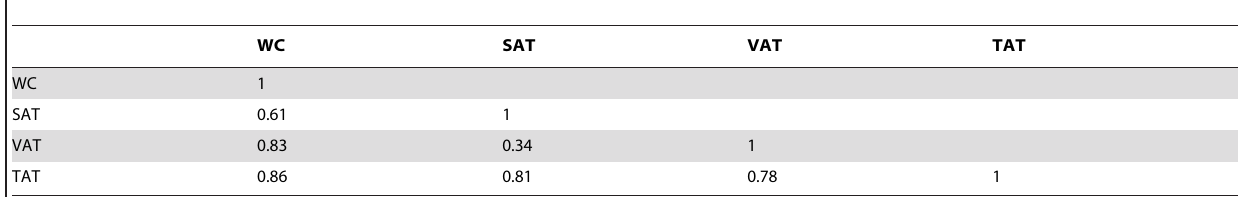
Table 3. Spearman correlation coefficients between abdominal fat measurement on MRI in 326 subjects from the cholecystolithiasis group and the control